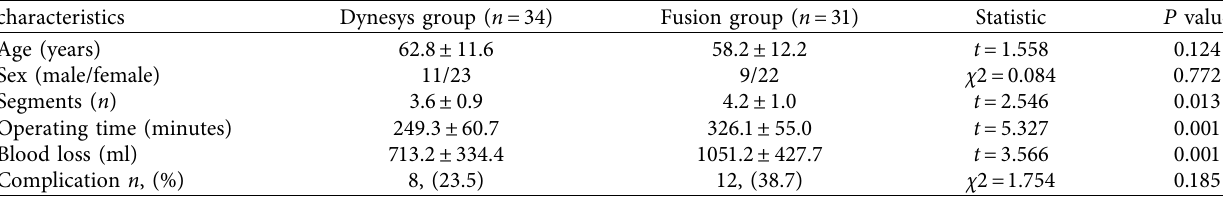
Table 1: Comparison of demographic and clinical characteristics of 2 groups of patients who underwent dynamic stabilization or fusion.